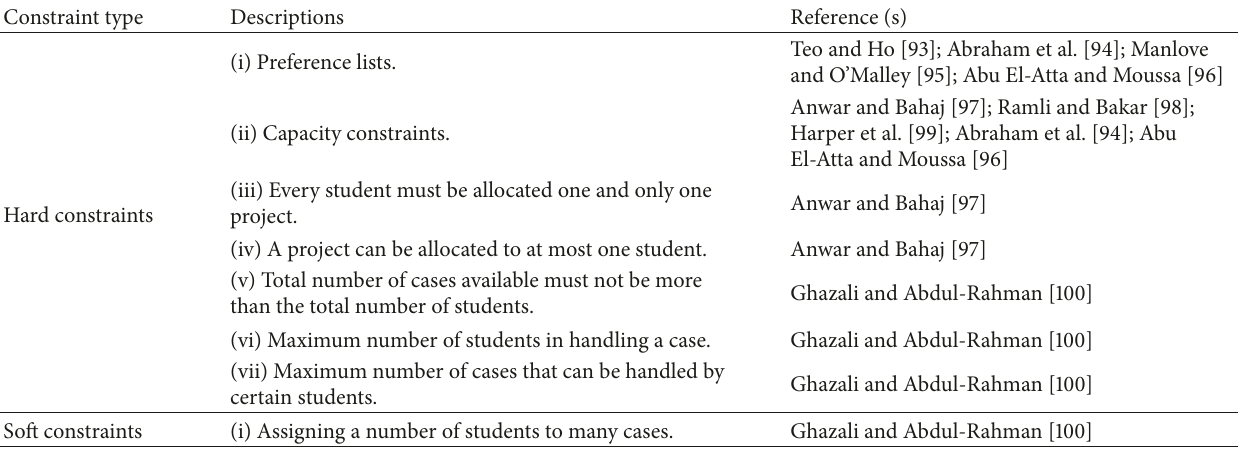
Table 10: The hard and soft constraints related to SPAP.